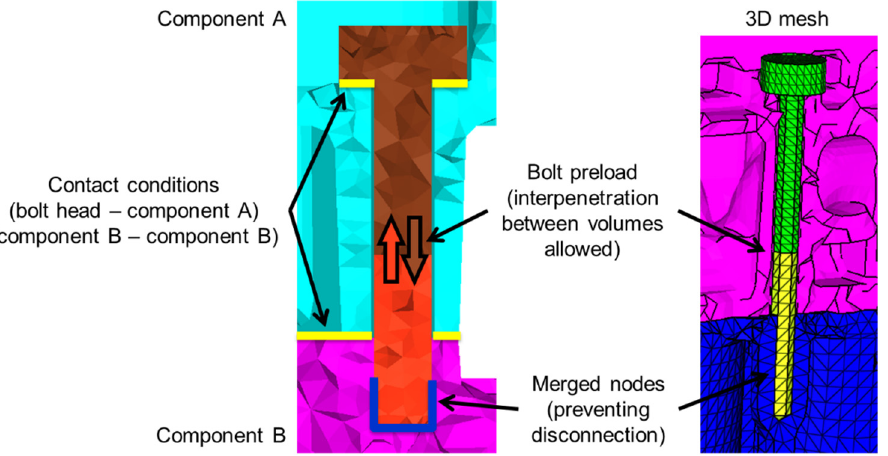
Figure 2. Full 3D modelling of bolts, with highlight of nonlinear contact and pretension in the bolt